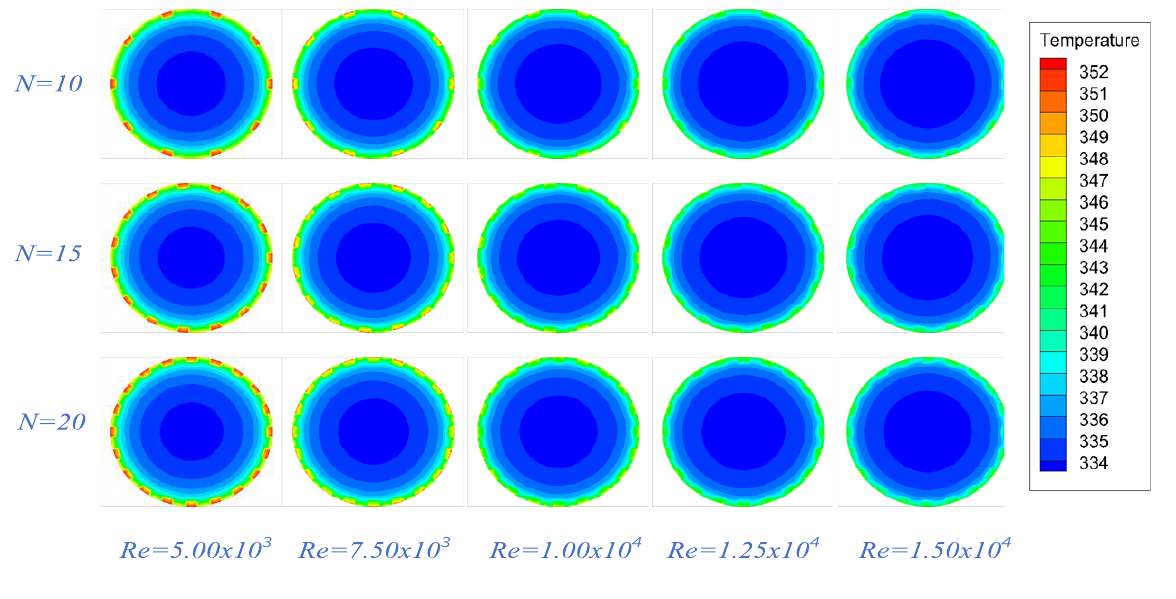
Figure 5. The fluid temperature and streamlines distribution of inserted tubes under different geometrical parameters. ( a ) α , ( b ) H , ( c ) N .